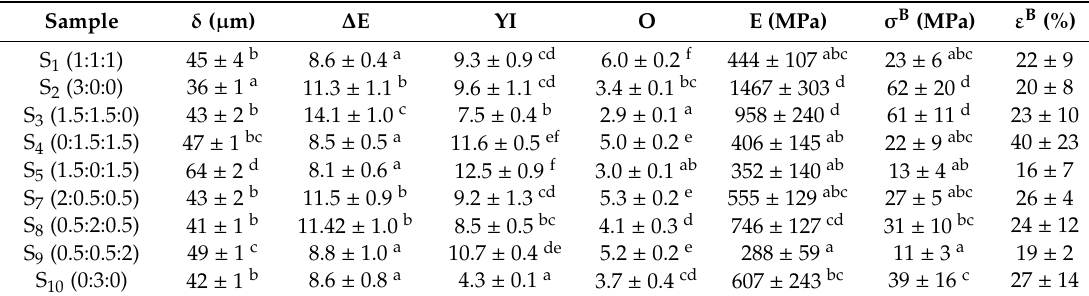
Table 4. Physical and mechanical properties of the edible films.